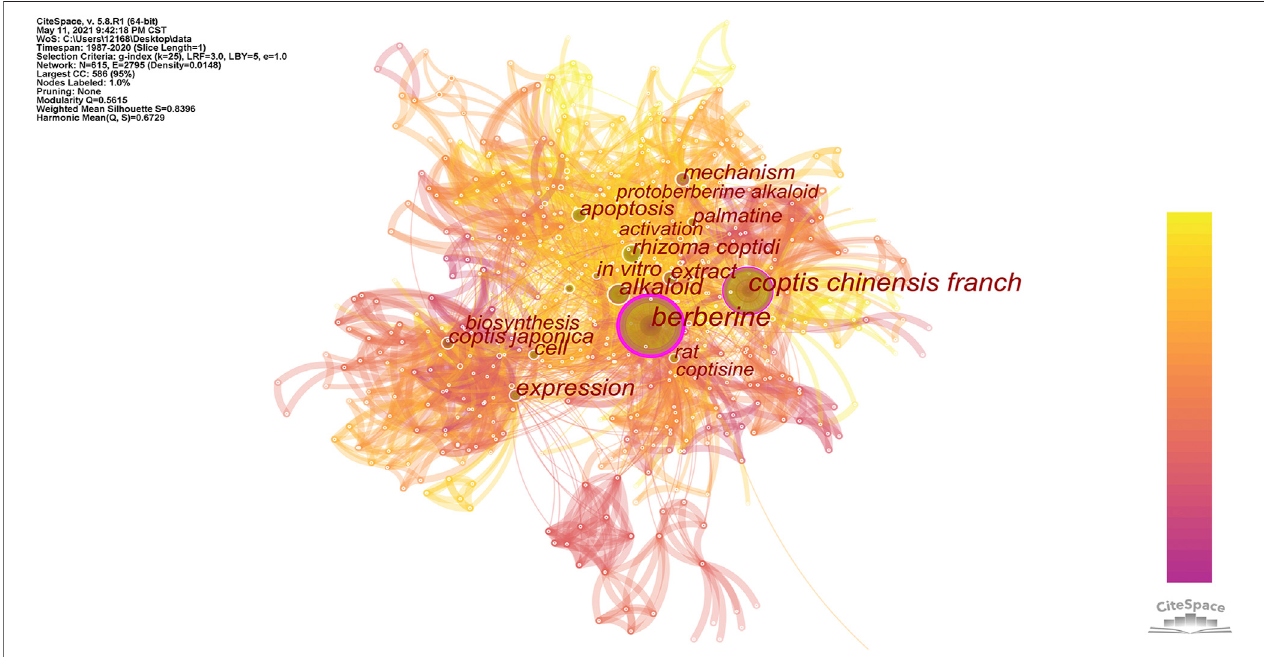
FIGURE 7 | Map of keyword co-occurrence related to Coptis research.